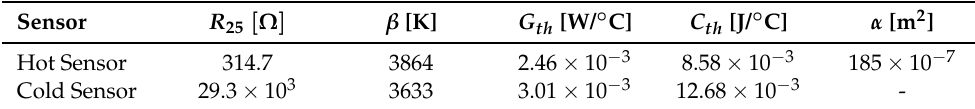
Table 10. Experimental CTD Prototype sensor parameters.